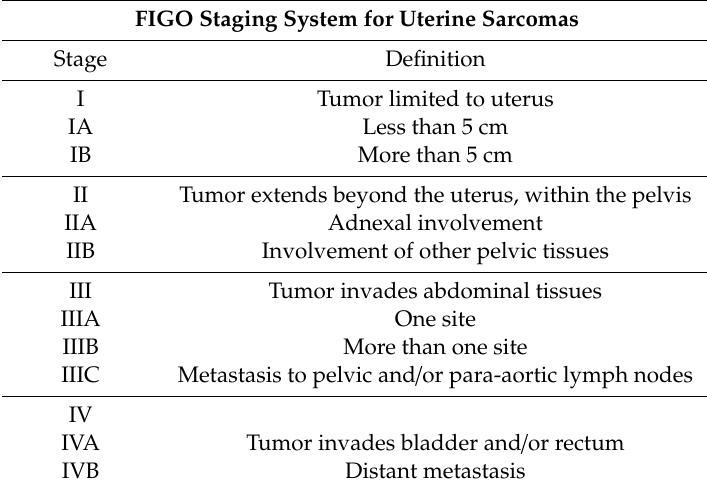
Table 1. Federation of Gynecology and Obstetrics (FIGO) staging for uterine sarcomas. FIGO Staging System for Uterine